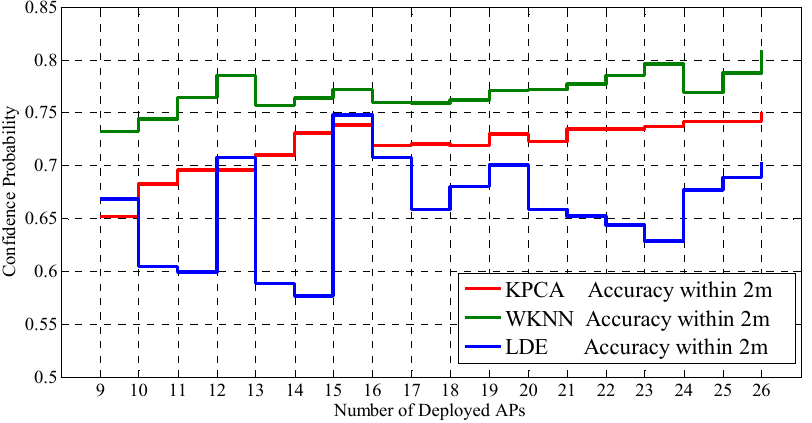
Figure 15. Performances of different positioning systems with different AP deployment under the condition that the positioning error distance is within 2 m and D = 8.